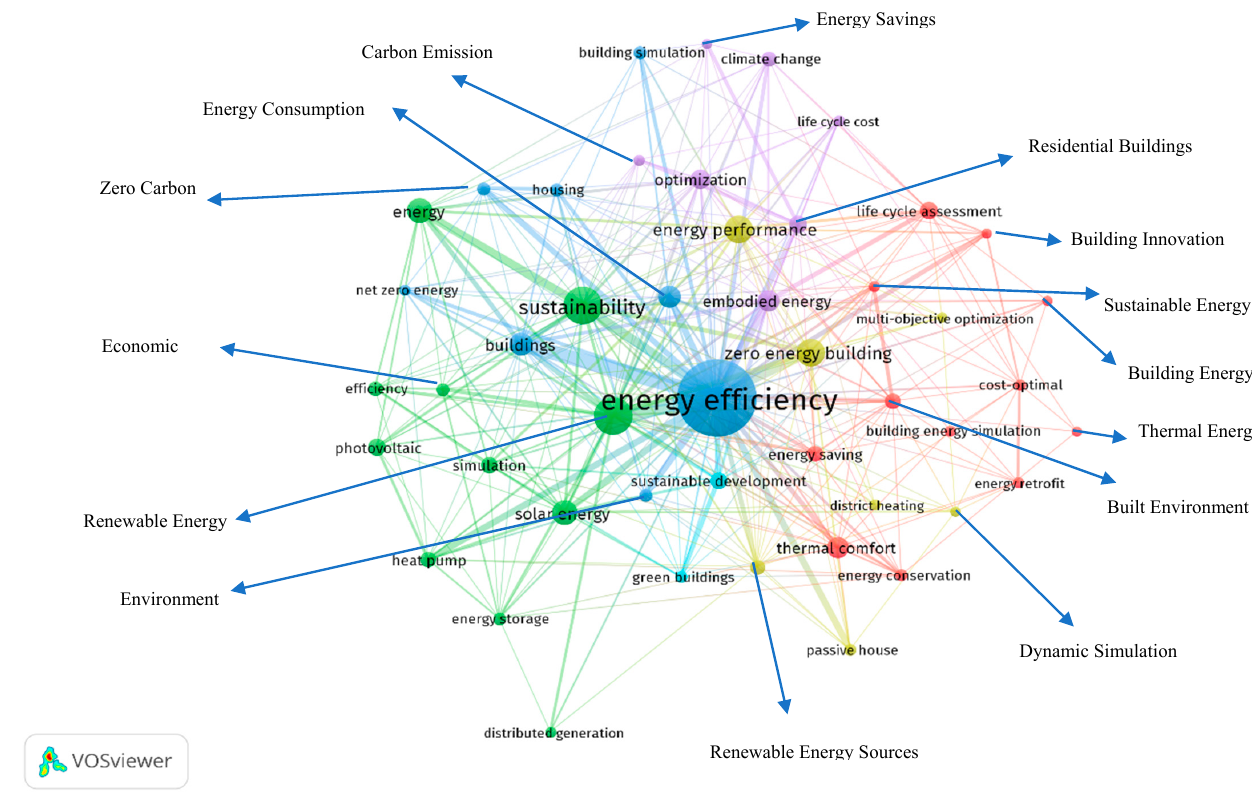
Figure 5. Research interests related to ZEBs and Energy Efficiency towards Sustainability (keywords co-occurrence).